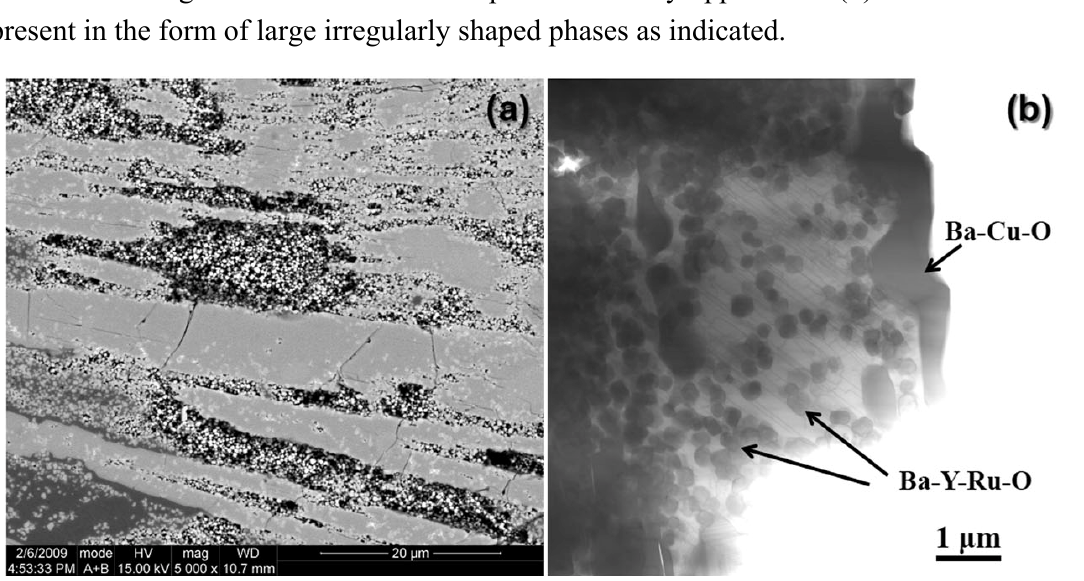
Figure 3. XRD scan of the bulk sample consisting of YBCO powder with 9 wt % RuO additions. Most peaks in the XRD scan can be indexed to YBCO or Ba